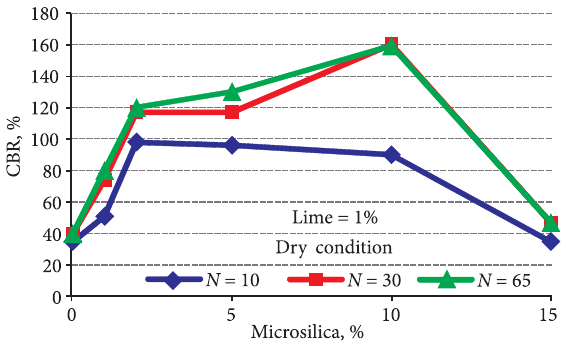
Fig. 8. CBR number of samples stabilized with 1% Lime and different values of Microsilica in dry condition (10, 30 and 65 blows)